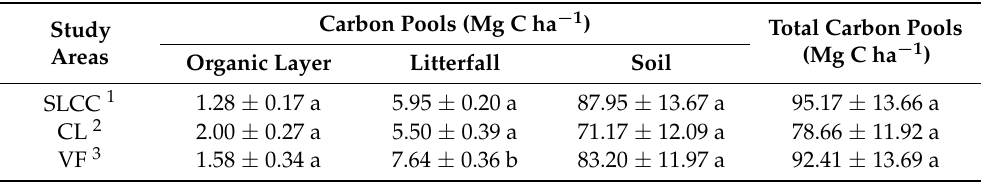
Table 5. Total carbon pools (organic layer, litterfall, and soil) in supervised logging with climber cutting areas (SLCC), conventional logging areas (CL), and virgin forest areas (VF).